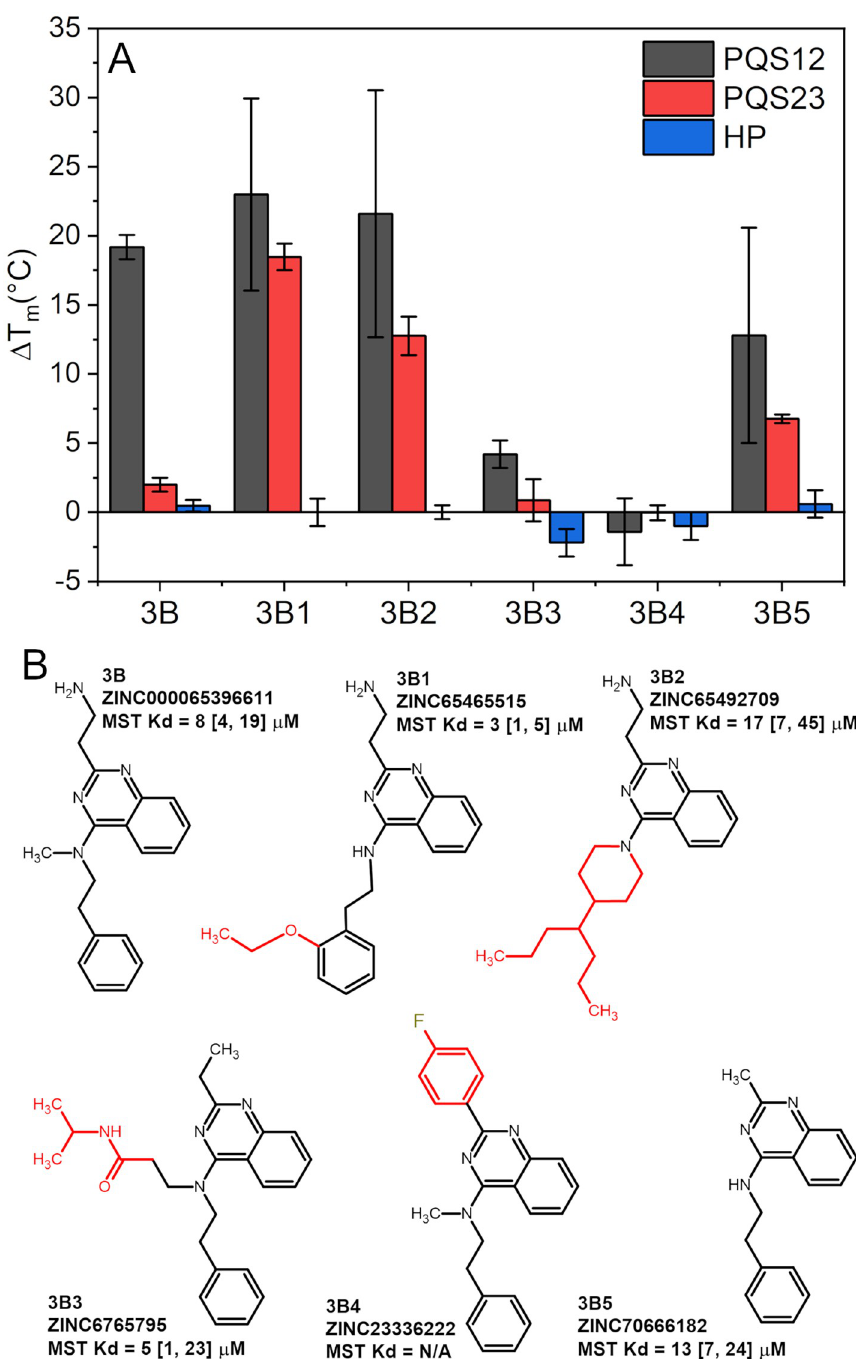
Fig 4. FTSA and MST SAR by catalogue results for 3B and its derivatives. (A) FTSA results of each derivative with their respective targets shown as average and standard deviation from triplicate measurements made on three independent days. (B) Molecular structure, ZINC ID, altered substituents (shown in red), and MST dissociation constant values (K d ) with 68.3% confidence intervals in brackets. “N/A” indicates that no binding was observed. See S4 Fig for representative curves and fits.